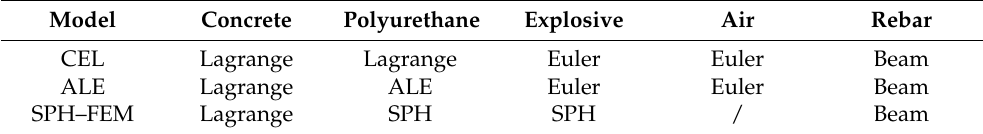
Table 1. Algorithm of the materials.